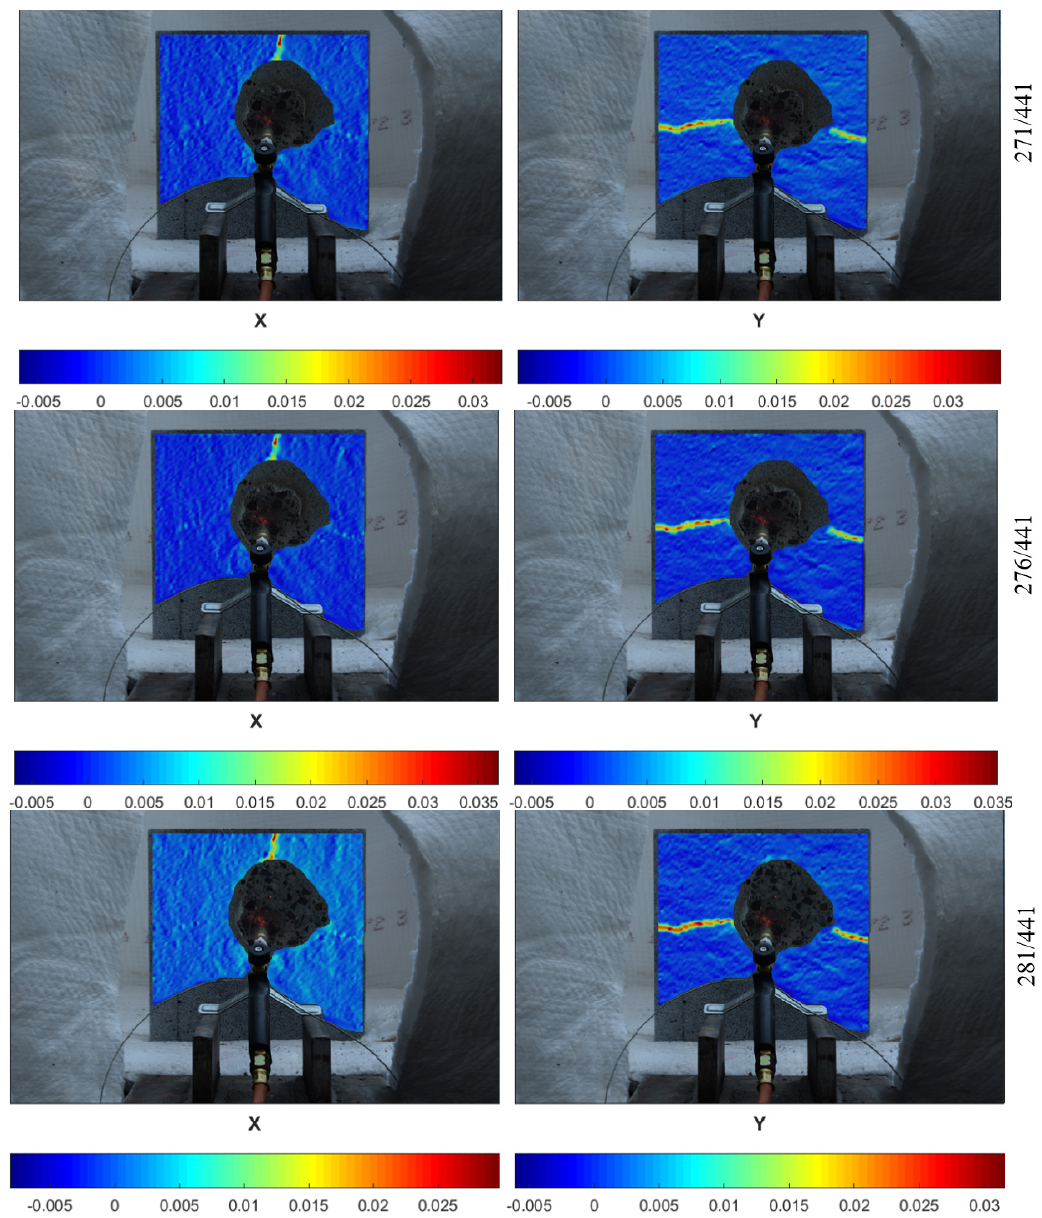
Figure 10. Deformation fields in the x- and y-directions for the medium specimen (200 × 200 mm).